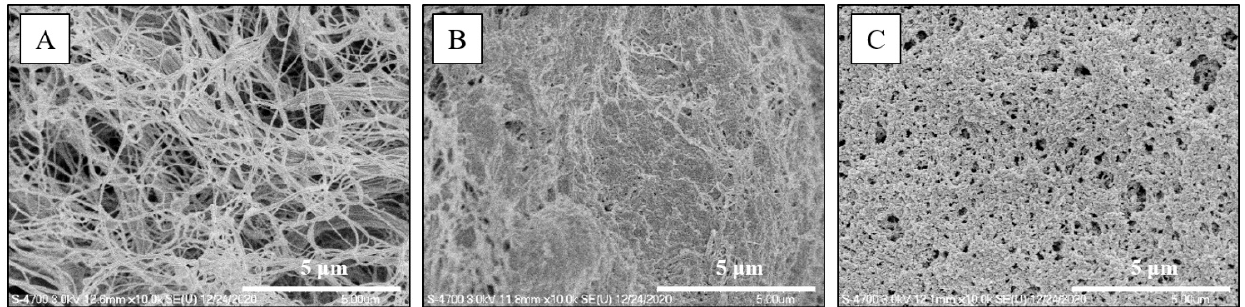
Figure 7. Submucosa surface examination using FE-SEM ( A ) normal saline, ( B ) Blue Eye, ( C ) CS/ β -GP 20%. (Scale bar is 5 μ m).